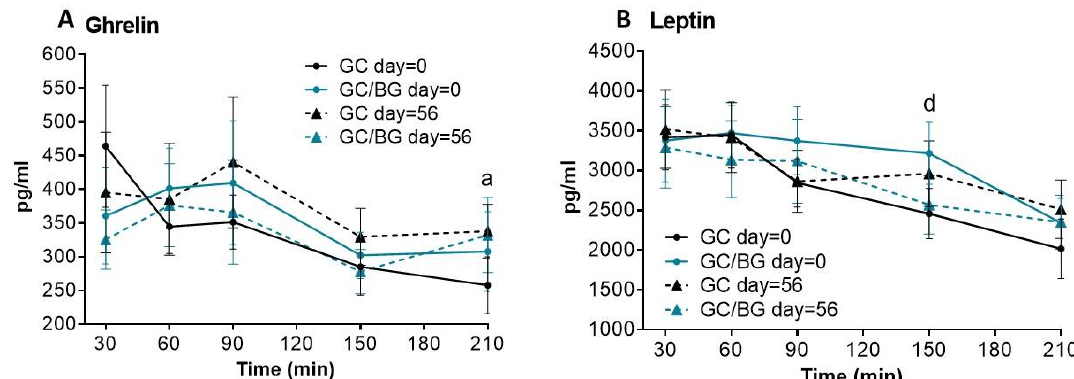
Figure 3. Plasma ghrelin and leptin concentrations from 30 to 210 min after GC and GC/BG consumption on day = 0 and day = 56. Values correspond to the means ± SEM, n = 9. Significant differences according to Wilcoxon’s signed rank sum test: ( A ) a p < 0.05 GC day = 0 compared with GC day = 56. ( B ) d p < 0.05 GC day = 0 compared with GC/BG day = 0.